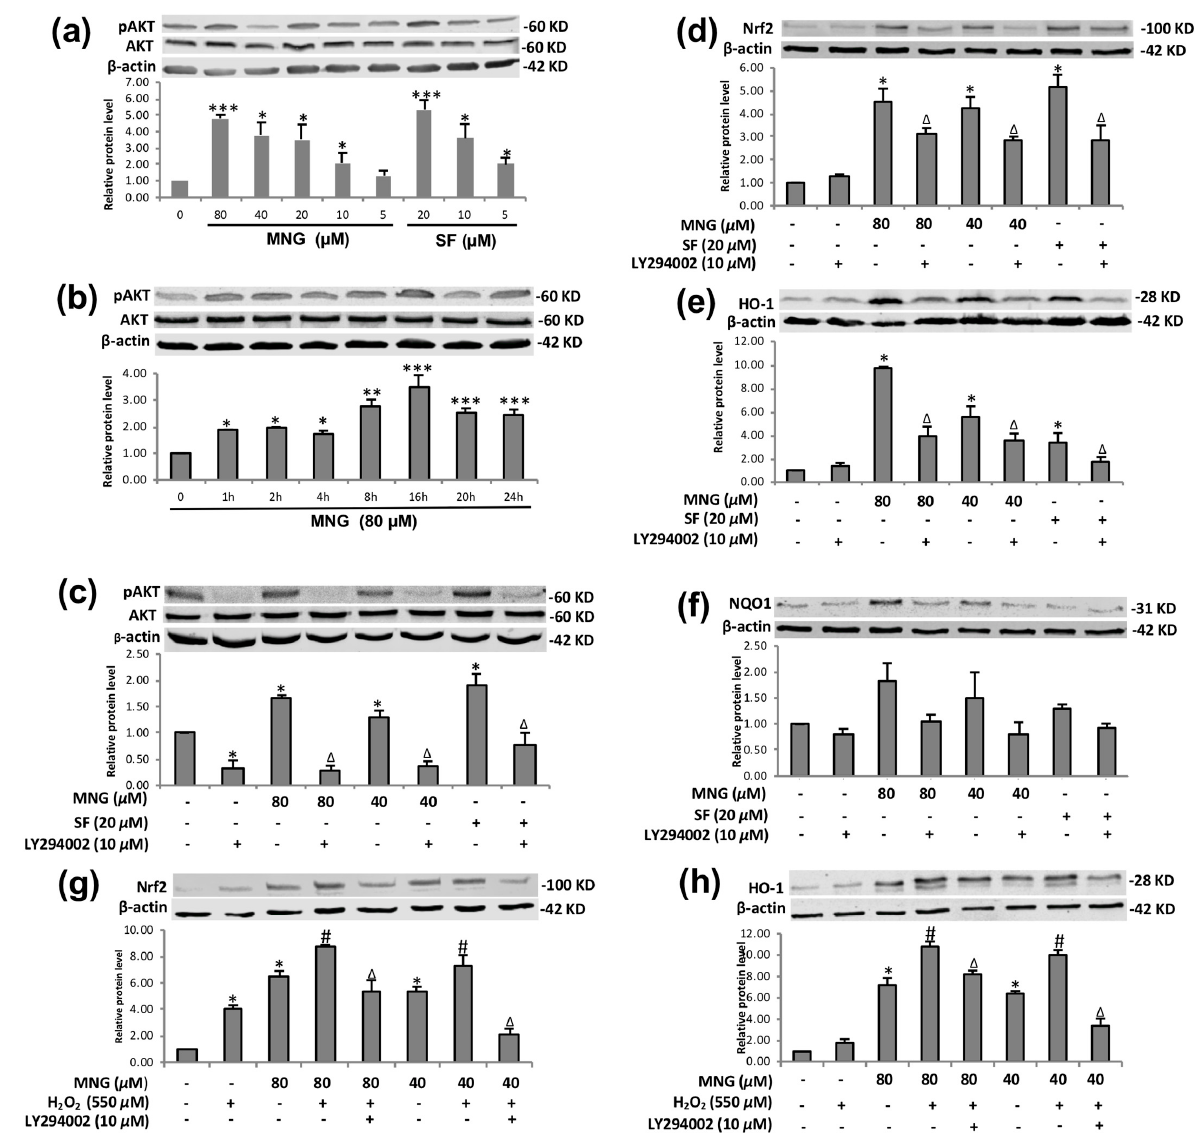
Figure 8. MNG stimulated Nrf2/HO-1 partially via the PI3K/Akt pathway in EA.hy 926 cells. ( a ) EA.hy926 cells were treated with 0–80 μ M MNG for 24 h, and the protein levels of p-Akt were determined by using Western blot. ( b ) Cells were treated with 80 μ M MNG for various time periods, and the protein levels of p-Akt were determined by using Western blot. ( c – f ) . After preincubation with 10 μ M LY294002 for 2 h, cells were cotreated with 40, 80 μ M MNG and 20 μ M SF for an additional 24 h, and the protein levels of p-Akt, Akt, Nrf2, HO-1 and NQO1 were then detected by using Western blot. * p < 0.05, ** p < 0.01, *** p < 0.001 vs. control group, Δ p < 0.05 vs. 40, 80 μ M MNG or 20 μ M SF. ( g , h ) After preincubation with 10 μ M LY294002 and 40 or 80 μ M MNG for 24 h, cells were cotreated with 550 μ M H 2 O 2 for an additional 6 h; the protein levels of Nrf2 and HO-1 were then detected by using Western blot. * p < 0.05 vs. control group, # p < 0.05 vs. 550 μ M H 2 O 2 group, Δ p < 0.05 vs. 40, 80 μ M MNG + 550 μ M H 2 O 2 group. Data are the means ± SEM of 3 independent experi- ments.